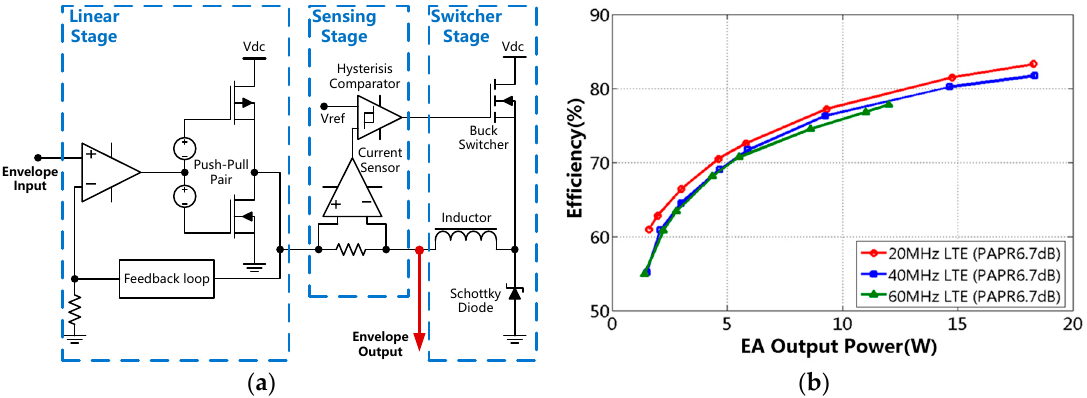
Figure 8. ( a ) Simplified hybrid envelope amplifier (EA) block diagram; ( b ) EA efficiency versus output power of the envelope signals.